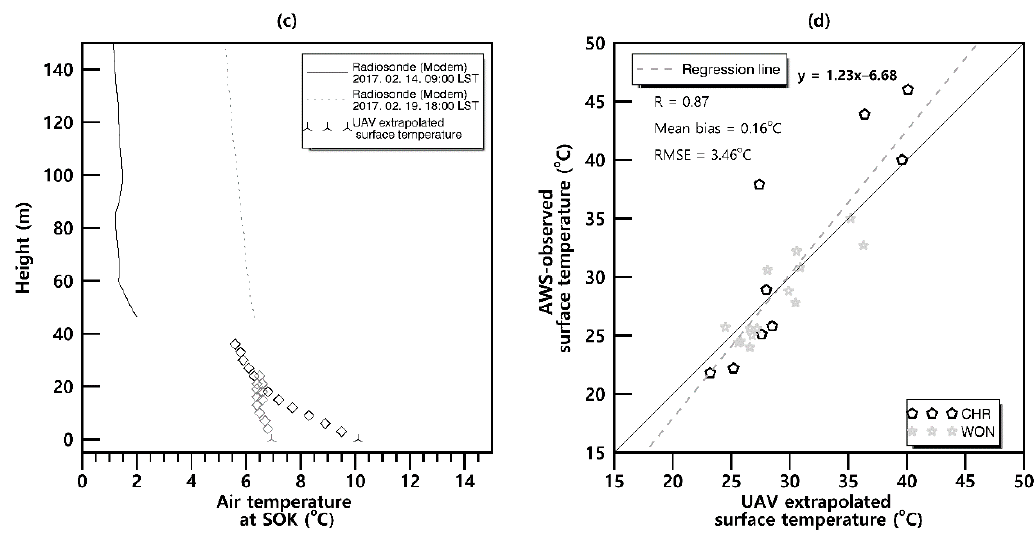
Figure 4. Comparison of UAV-observed air temperature profiles (black and gray symbols) with radiosonde-observed air temperature profiles (black solid and gray dotted lines) at ( a ) CHR, ( b ) WON, and ( c ) SOK; ( d ) a comparison of extrapolated surface temperature using UAV-observed air temperature profiles with AWS-observed surface temperatures.